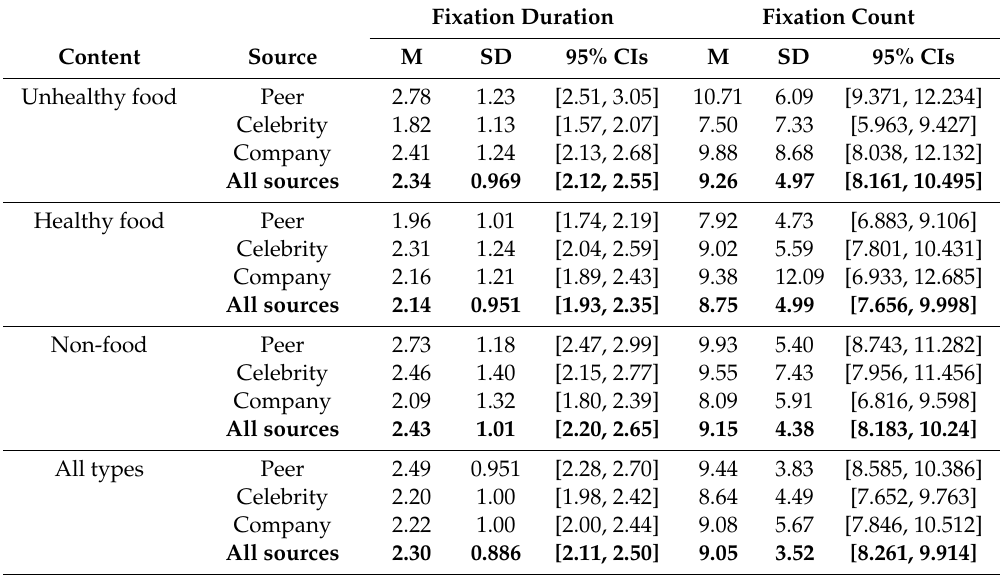
Figure 12. Interaction between fixation count and source of ad for 3 types of ad.